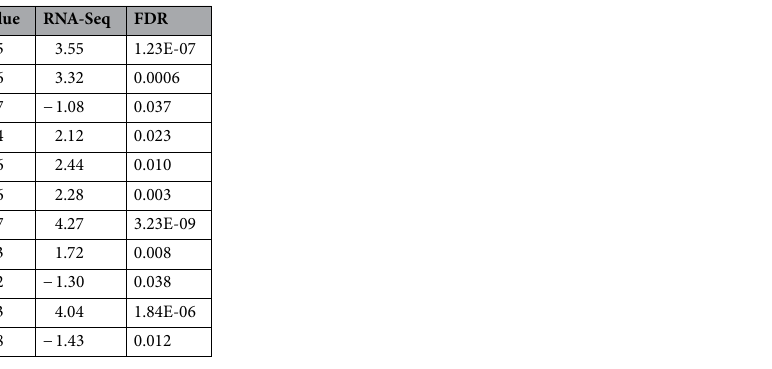
Table 3. Relative expression (Log2FC) and statistical significance between normal and FHS-affected broilers obtained with qPCR and comparison with RNA-Seq results for 11 candidate genes.